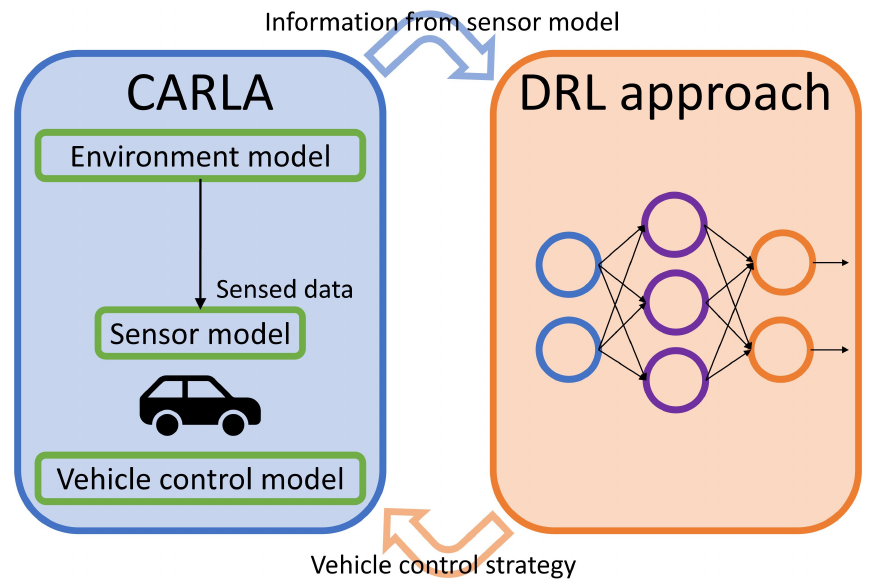
Figure 3. The relationship between CARLA and the control